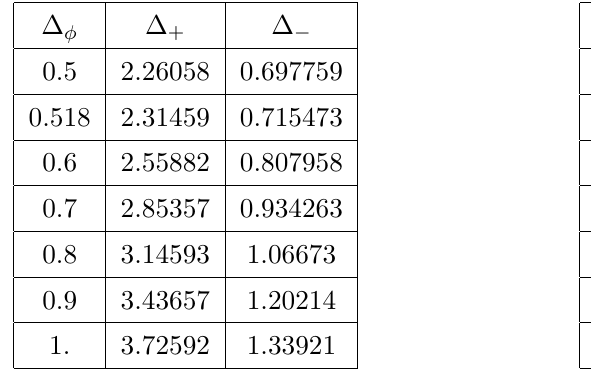
Table 4. List of (cid:1) + ; (cid:1) (cid:0) for various (cid:1) (cid:30) , d = 4.